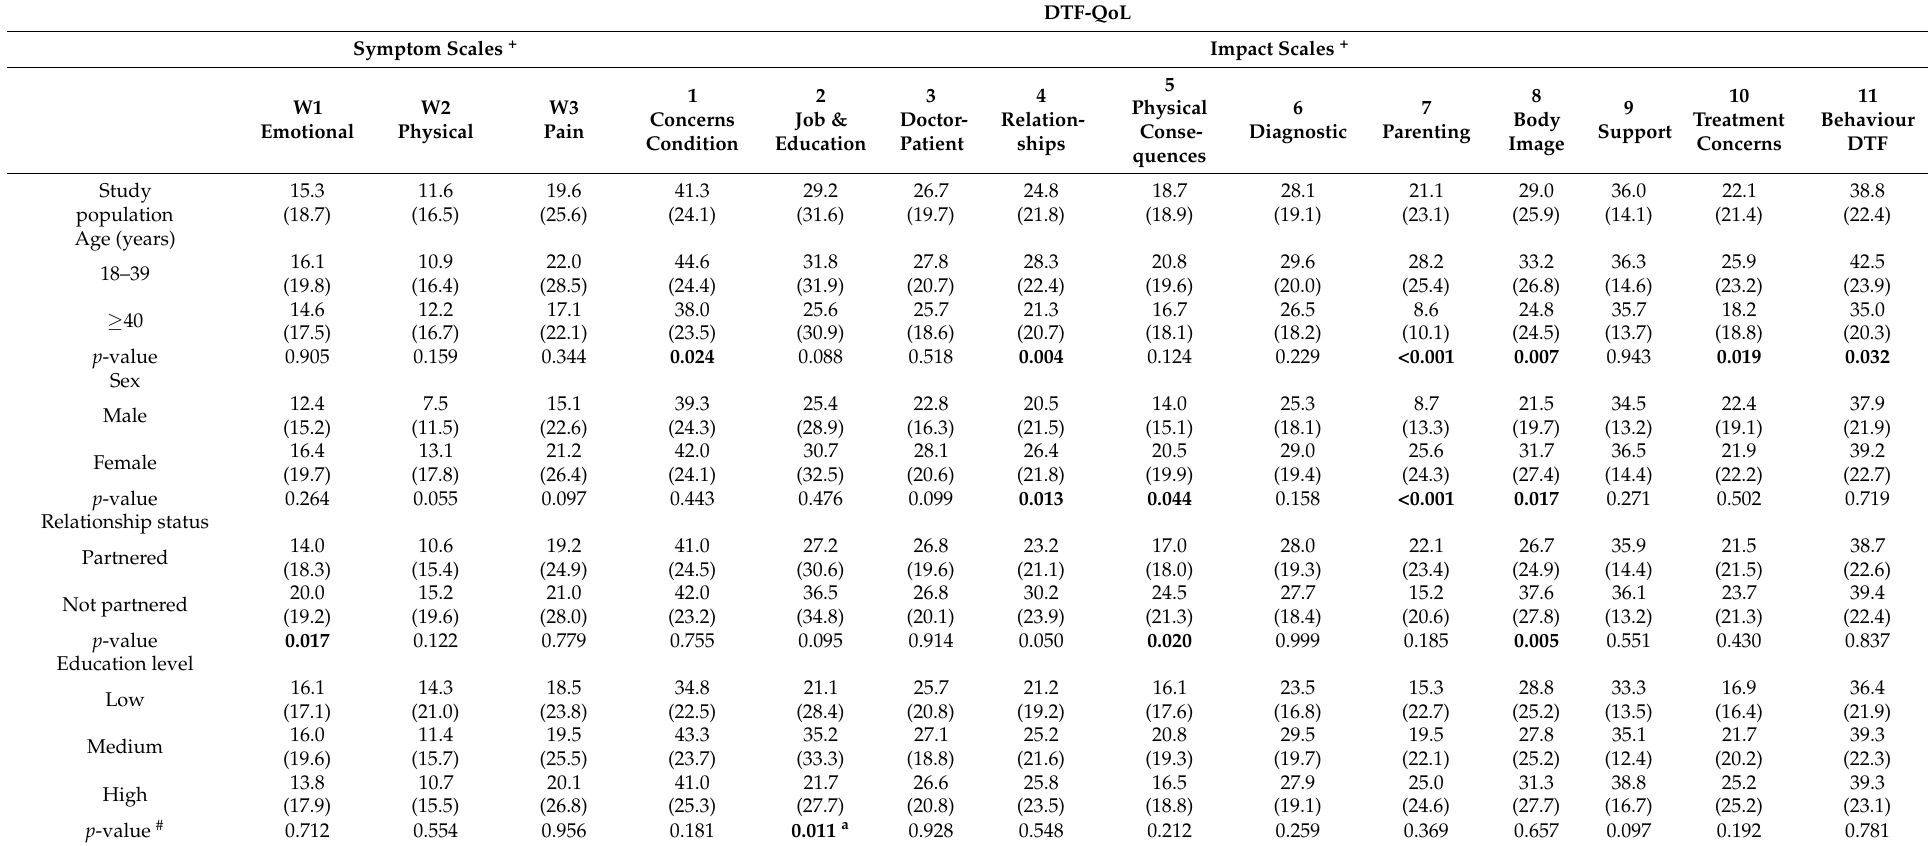
Table 2. Mean DTF-QoL scores ( ± SD) in relation to socio-demographic and clinical